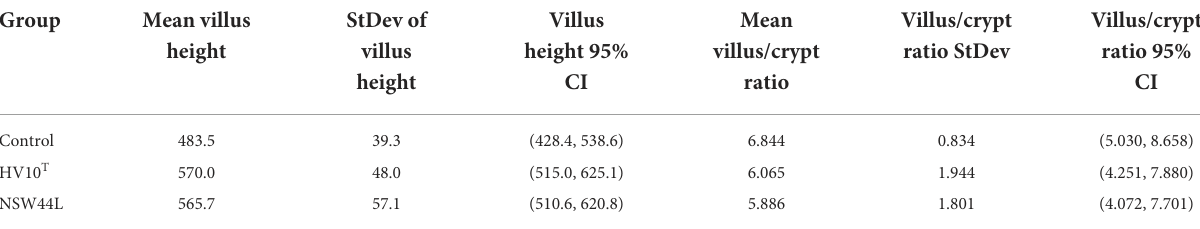
TABLE 2 Villus height and villus/crypt ratios.